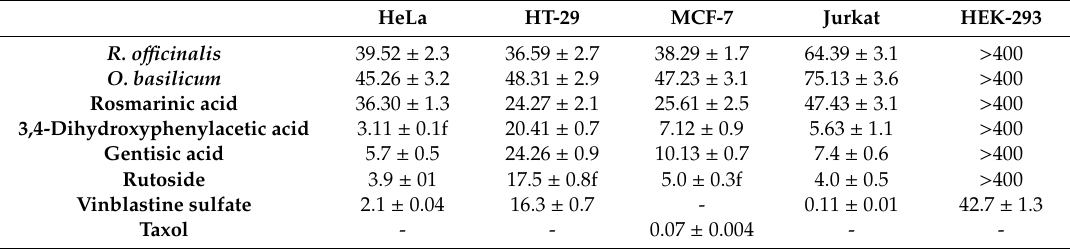
Table 3. Antiproliferative activity (IC 50 ( µ g mL − 1 )) of R. o ffi cinalis and O. basilicum leaf